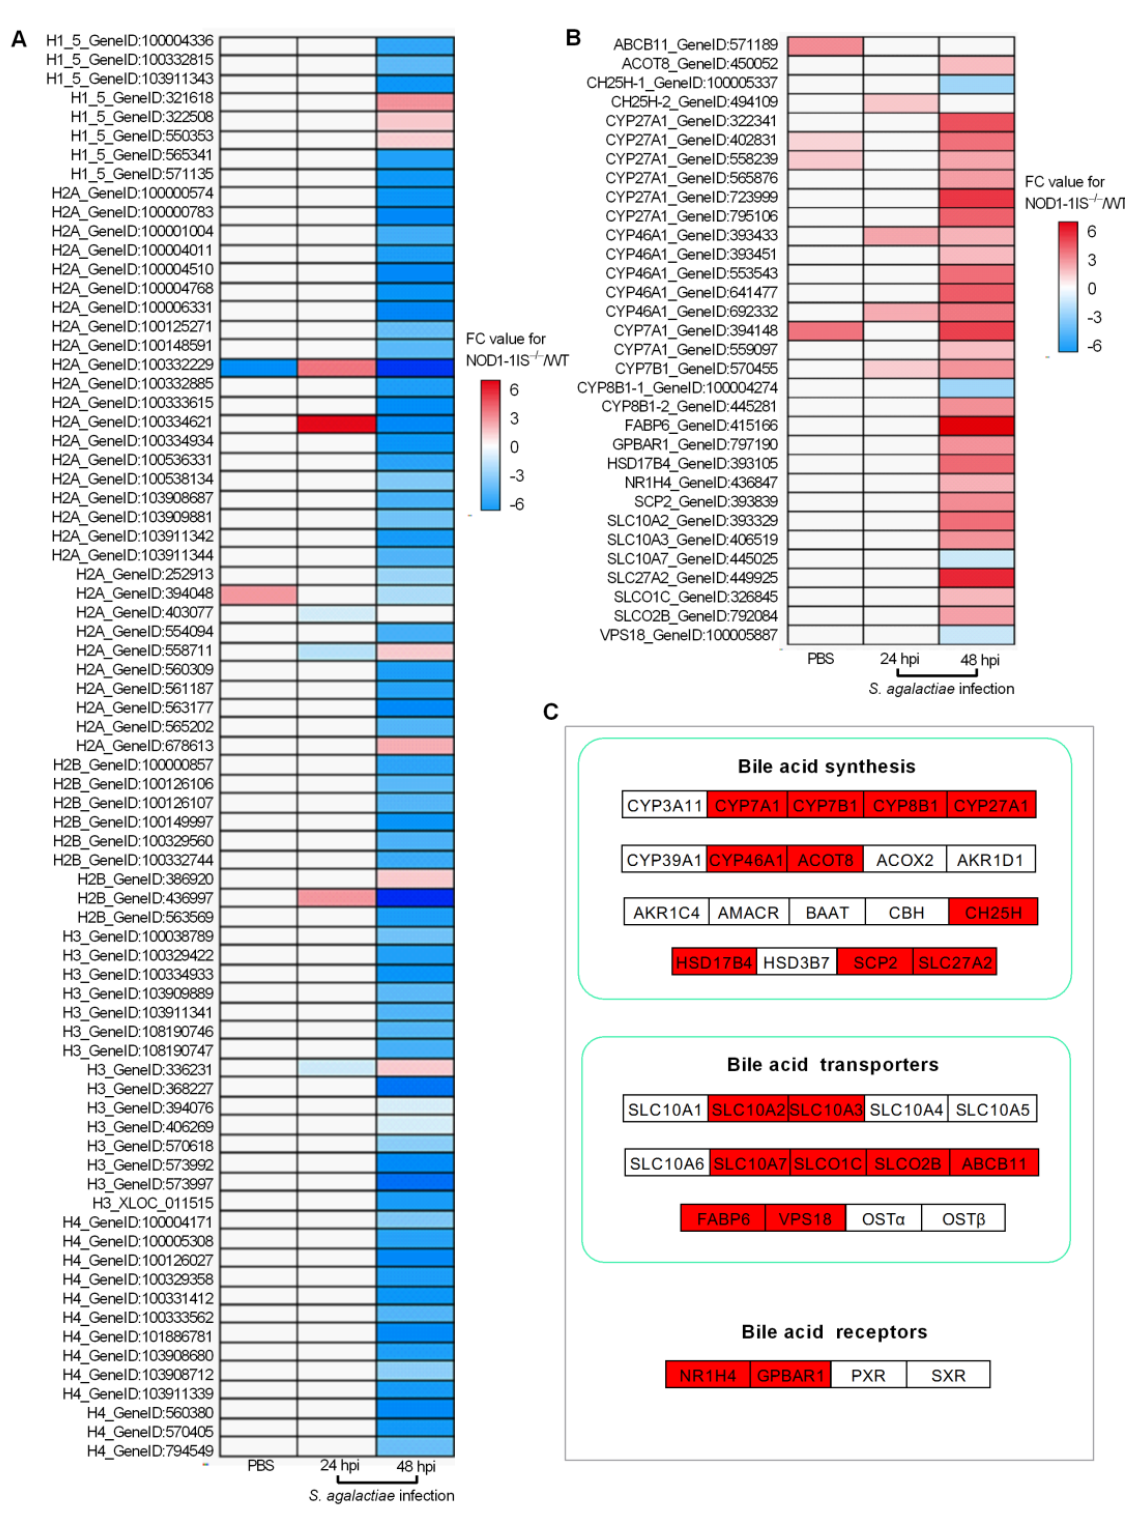
Figure 4. The effect of NOD1 deficiency on the transcriptional regulation of histones and many of the genes involved in bile acid metabolism. ( A ) Heatmap of differently expressed histones. ( B ) Heatmap of bile acid-related DEGs. ( C ) The expression trends of bile acid-related genes involved in bile acid synthesis, bile acid transporters, and bile acid receptors. The genes in red background were found to be differently expressed in the present study.